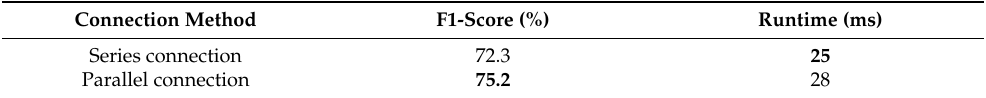
Figure 9. The decoder with the series connection. Table 7. Comparison results on CULane